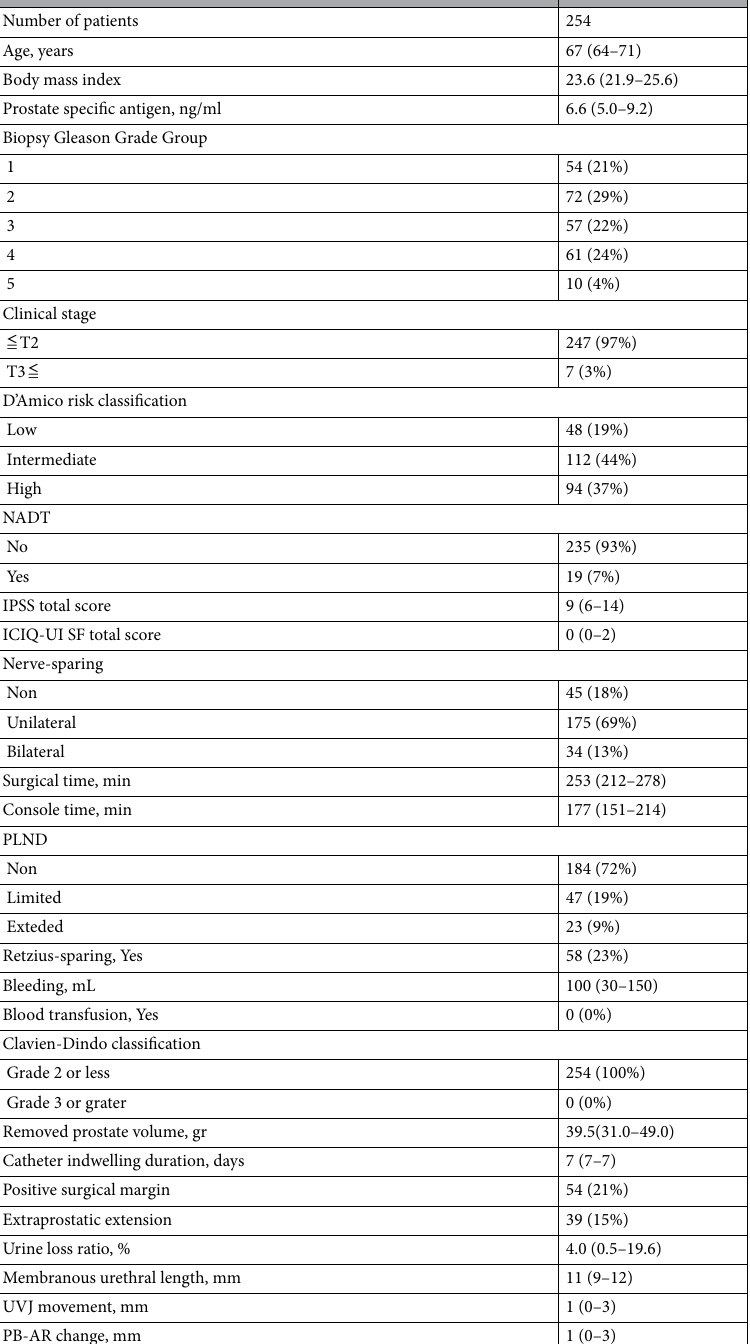
Table 1. Clinicopathological characteristics of robot-assisted radical prostatectomy. IQR interquartile range, ICIQ-UI SF International Consultation on Incontinence Questionnaire-Urinary Incontinence Short Form, IPSS International prostate symptom score, NADT neoadjuvant androgen deprivation therapy, PB-AR distance from pubic bone to anterior rectum, PLND pelvic lymphnode dissection, UVJ urethrovesical